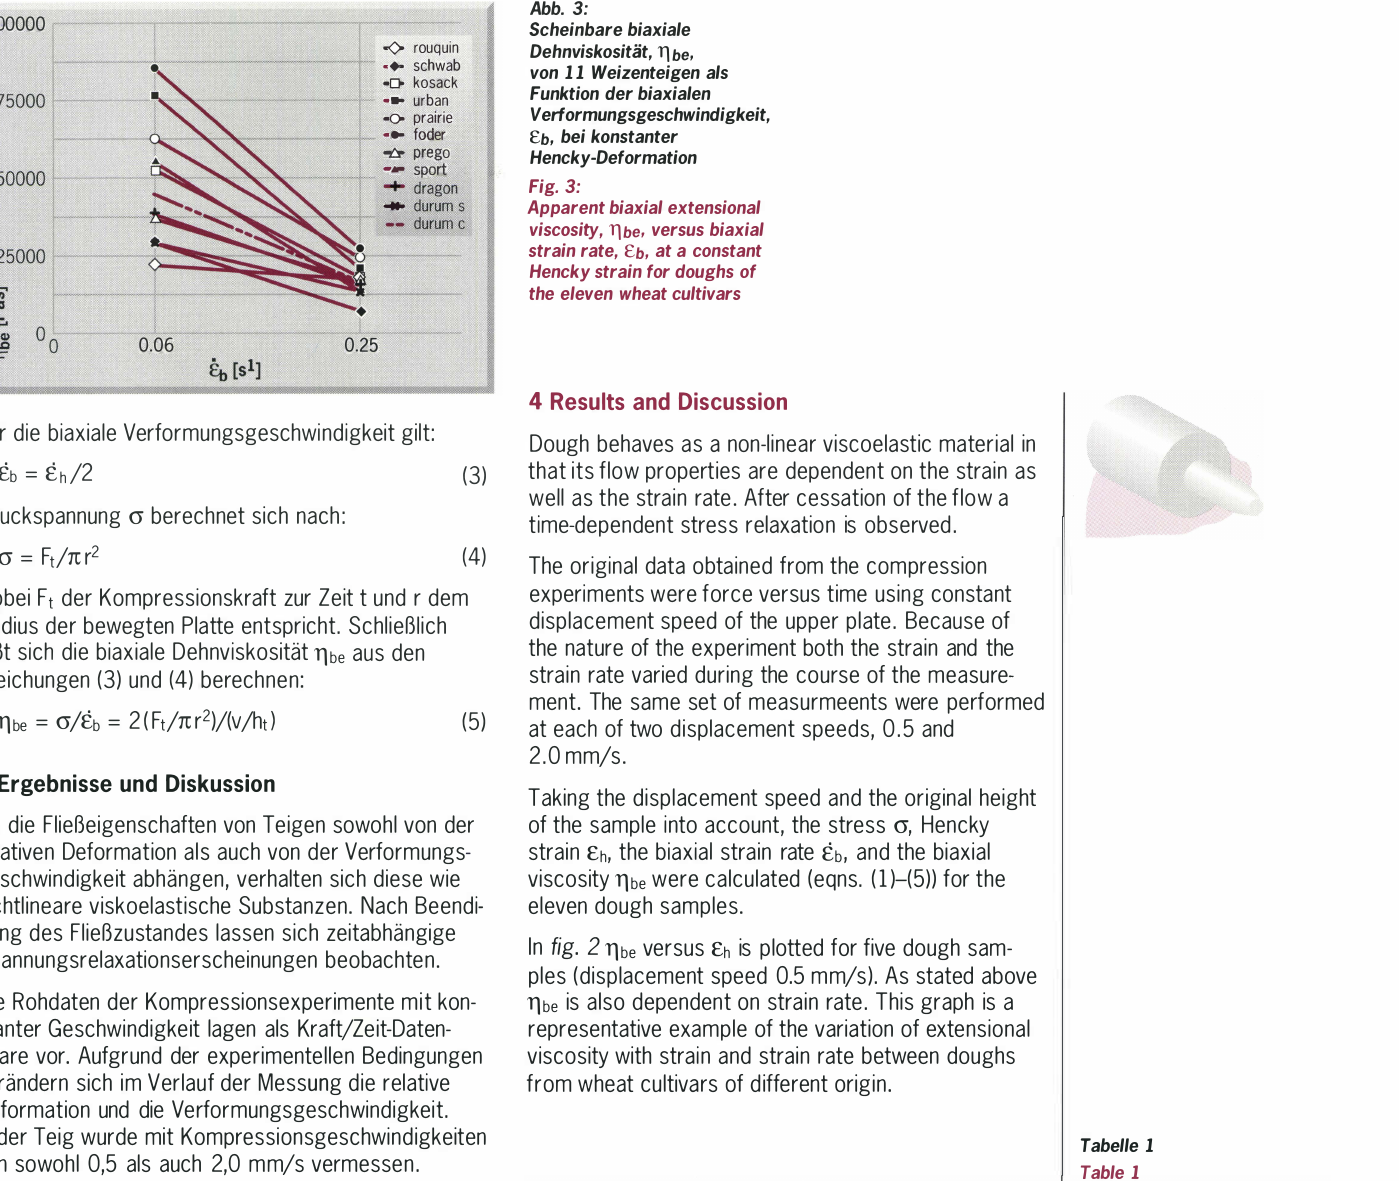
Wasser ab. Backeigensch. Water abs.